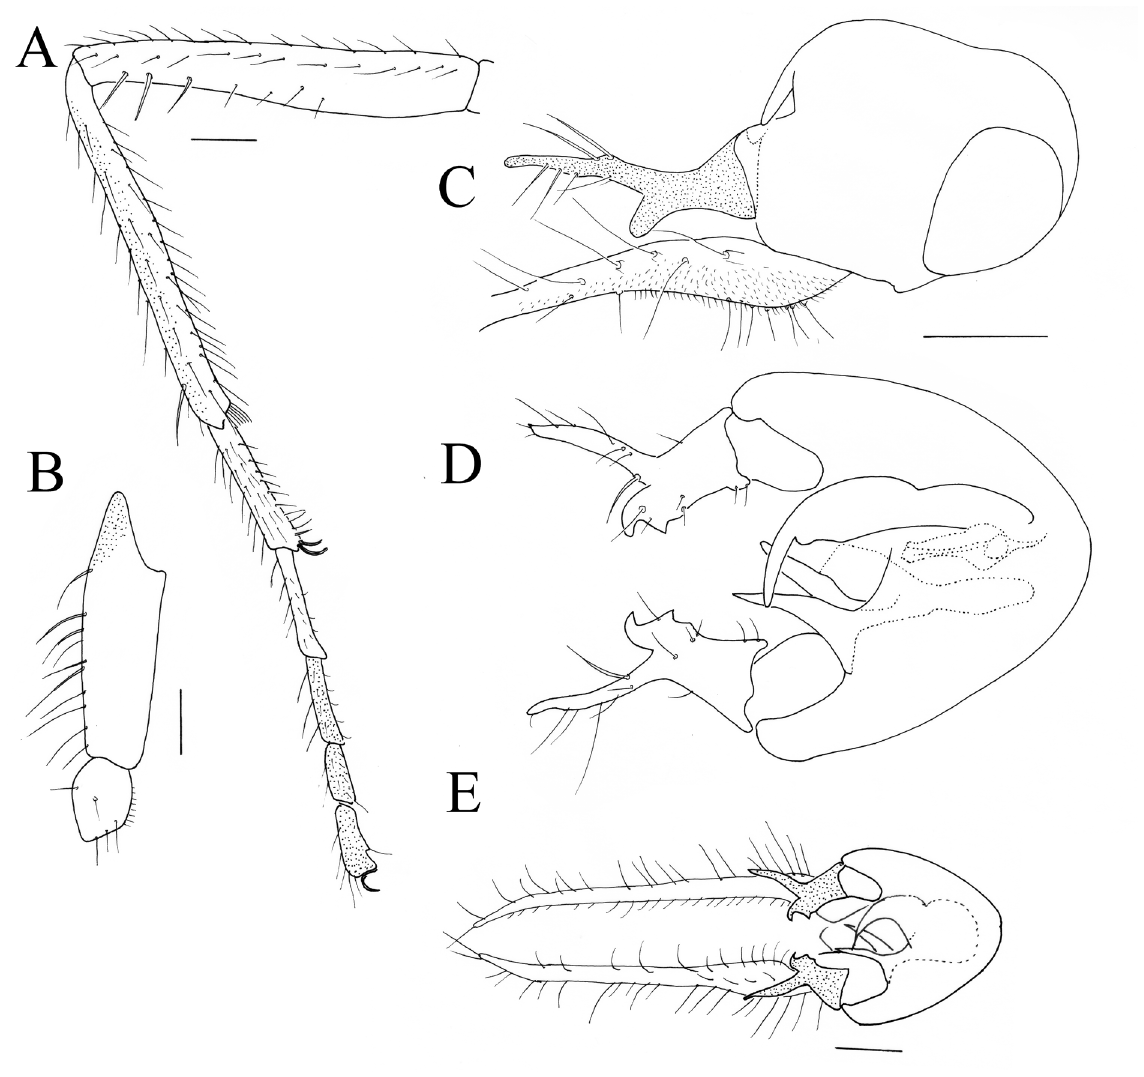
Fig. 4. Rhaphium spinulatum sp. nov., holotype, ♂ (RBINS). A . Fore leg, posterior view. B . Fore coxa. C . Epandrium, lateral view. D . Epandrium, ventral view. E . Epandrium with cerci, ventral view. Scale bars: 0.1